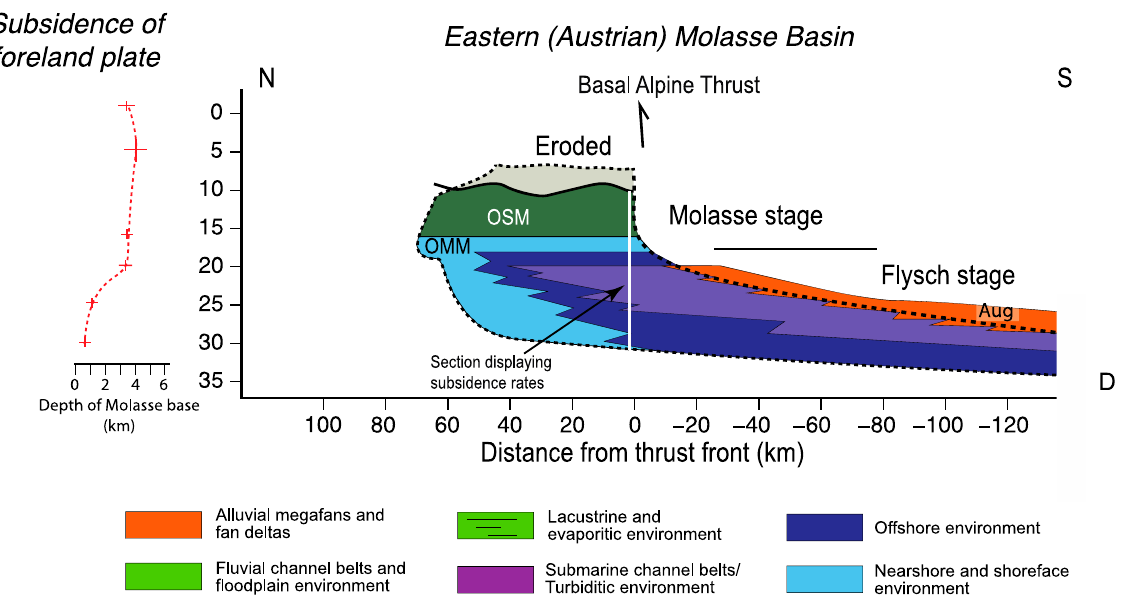
Figure 9. Subsidence pattern of the Molasse basin within a temporal framework. Because the sections are situated in the Plateau Molasse adjacent to either the Basal Alpine thrust (Austrian and French Molasse) or to the front of the Subalpine Molasse, the deflection of the foreland plate was only marginal in these areas at 30 Ma and before. ( A ) Chronological diagram for the Western (French) Molasse basin near Chambery at the site labelled with F in Figure 2 (Table 1). Sedimentation occurred in a wedge-top position at the proximal basin border. The transition from the Flysch to the Molasse stage occurred at c. 30 Ma, and the propagation rate of the Alpine thrust front was nearly constant between 30 and 5 Ma. After 20 Ma, the distal basin border was defined by the western limit of the Bresse graben (Figure 2). Before 20 Ma, the subsidence rates of the foreland plate in this part of the basin were negligible. They started to increase after 20 Ma. ( B ) Chronological diagram for a section across the Central (Swiss) Molasse basin near Lucerne (see site labelled as S in Figure 2 and Table 2). The transition from the Flysch to the Molasse stage occurred at c. 30 Ma. The propagation rate of the Alpine thrust front decreased at c. 30 Ma. In the basin axis, the subsidence rates of the foreland plate continuously increased. ( C ) Diagram for the boundary between the eastern and western Molasse basin near Munich (site labelled as G in Figure 2). The subsidence pattern was taken from the data displayed in Table 3. The basin evolution shares similarities to the Swiss and Austrian portions of the Molasse basin. Similar to the Swiss basin, the transition from basin underfill to overfill occurred at c. 30 Ma. However, the subsidence history can be compared with the Austrian basin in the sense that the subsidence rates where high before 20 Ma, after which they slowed down. ( D ) Chronological diagram for a section across the eastern (Austrian) Molasse basin near Salzburg (see Table 4 for database, and site labelled as A in Figure 2). The time between 30 and 20 Ma was characterized by a rapid northward propagation of the Alpine thrust front. The fluvio-deltaic sediments of the Augenstein Formation (Aug) accumulated in a wedge-top position. At 20 Ma, the Austrian Molasse basin transitioned from the underfilled Flysch stage into the overfilled Molasse stage, and the deformation at the Alpine thrust front came to a halt shortly after 20 Ma. The distal basin border was most likely limited by a Hercynian fault, which currently separates the Bohemian massif from the Molasse basin (Figure 2). In the area north of the modern Alpine front, the subsidence rates of the foreland plate increased until 20 Ma. After that time, the subsidence rate was constant and nearly negligible. NHF = North Helvetic Flysch, UMM = Lower Marine Molasse, USM = Lower Freshwater Molasse, OMM = Upper Marine Molasse, OSM = Upper Freshwater Molasse.